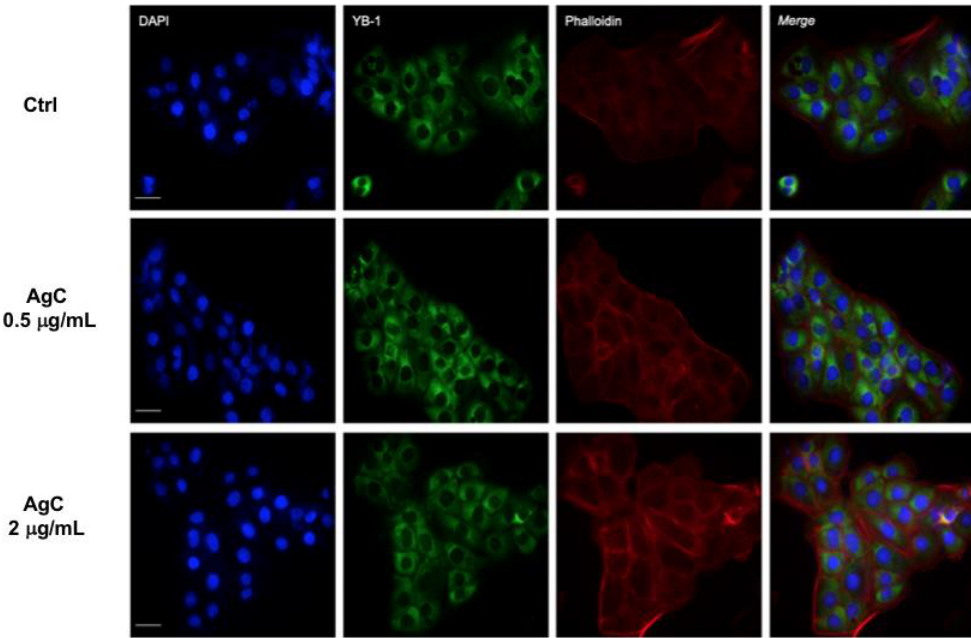
Figure 2. E ff ect of AgC on stress granules formation. HaCaT cells were seeded on a coverslip and treated (or not) with AgC at 0.5 or 2 µ g / mL for 24 h. Cells were then fixed and analyzed by TRITC-conjugated phalloidin staining (red) or indirect IF with the anti-YB1 antibody (green). Nuclei were stained with DAPI. Scale bar, 7 µ M. Images were acquired using a Nikon TE Eclipse 2000.